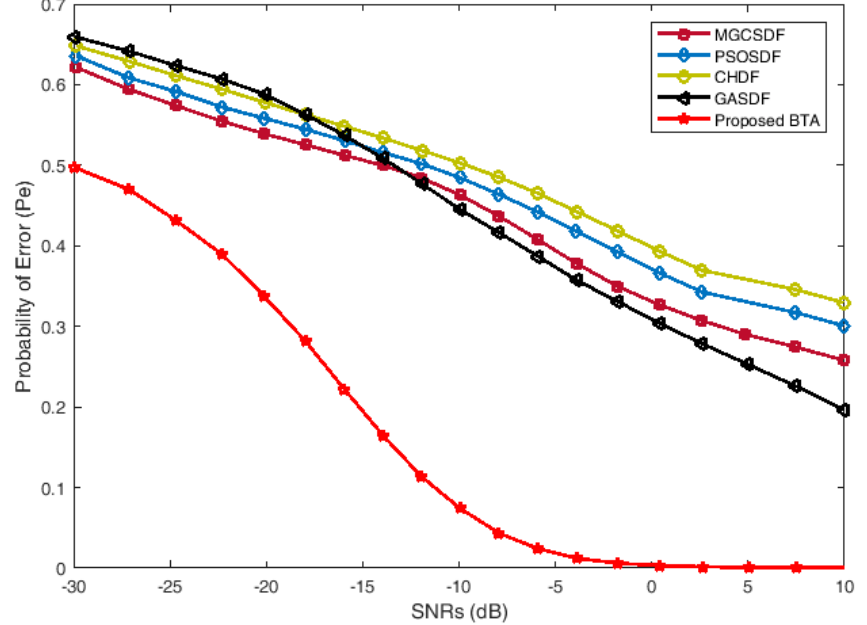
Figure 7. Probability of error vs. SNRs with always no category of malicious users (MUs).